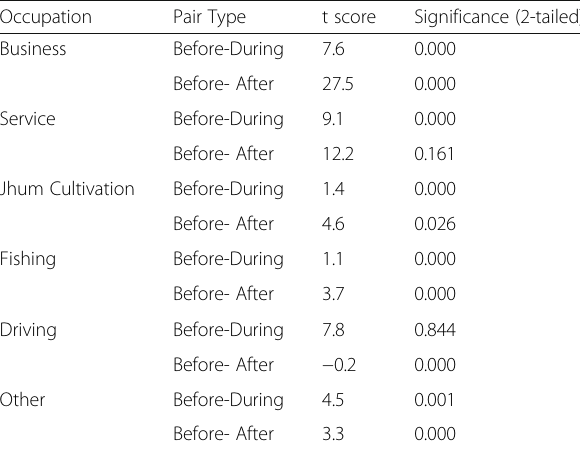
Table 7 Paired Samples Test for Detecting Significant Differences in